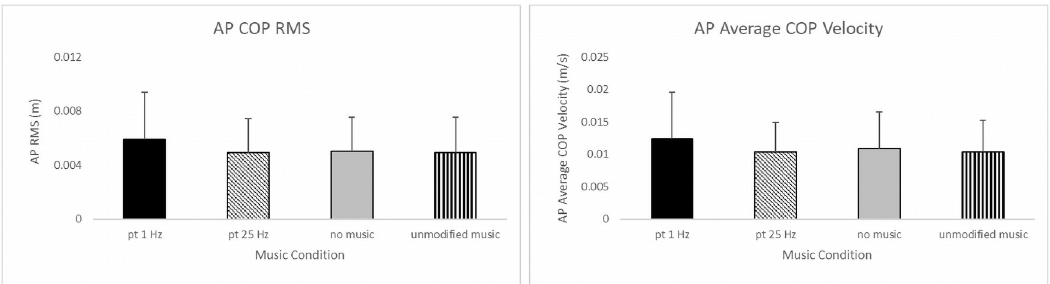
Fig 3. The effect of music on mean AP COP RMS (left), mean and mean AP Average COP velocity (right). Subject were exposed to no music, unmodified music, and music with volume shifting at 0.25 Hz and 0.1 Hz. Overall, sway was increased when listening to music with 0.1 Hz volume shifting. Error bars indicate the standard